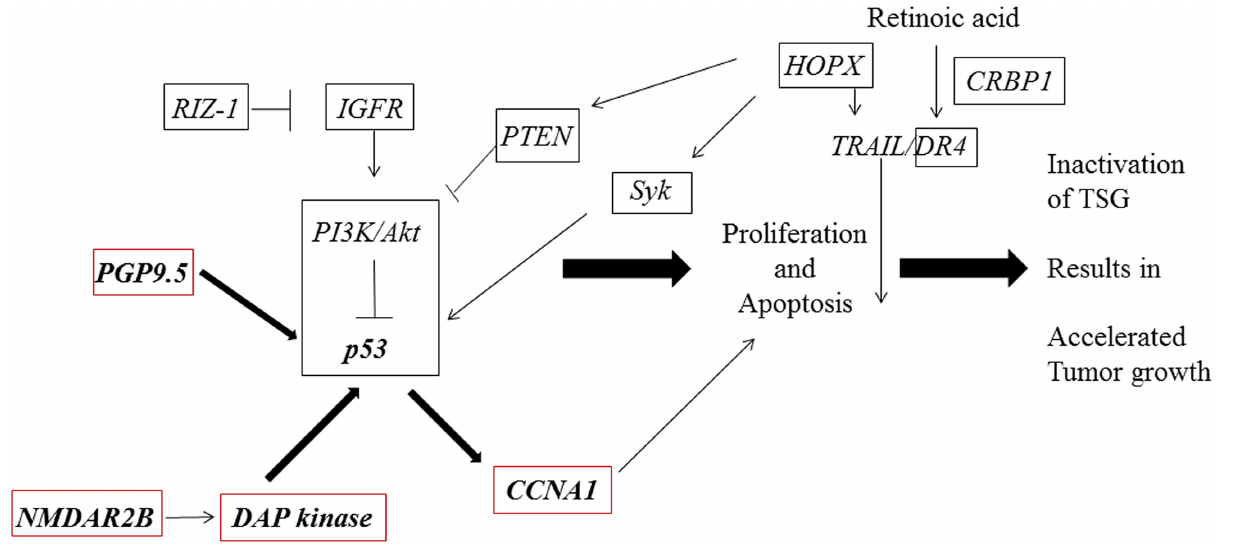
Fig 1. Epigenetic conversion in the p53